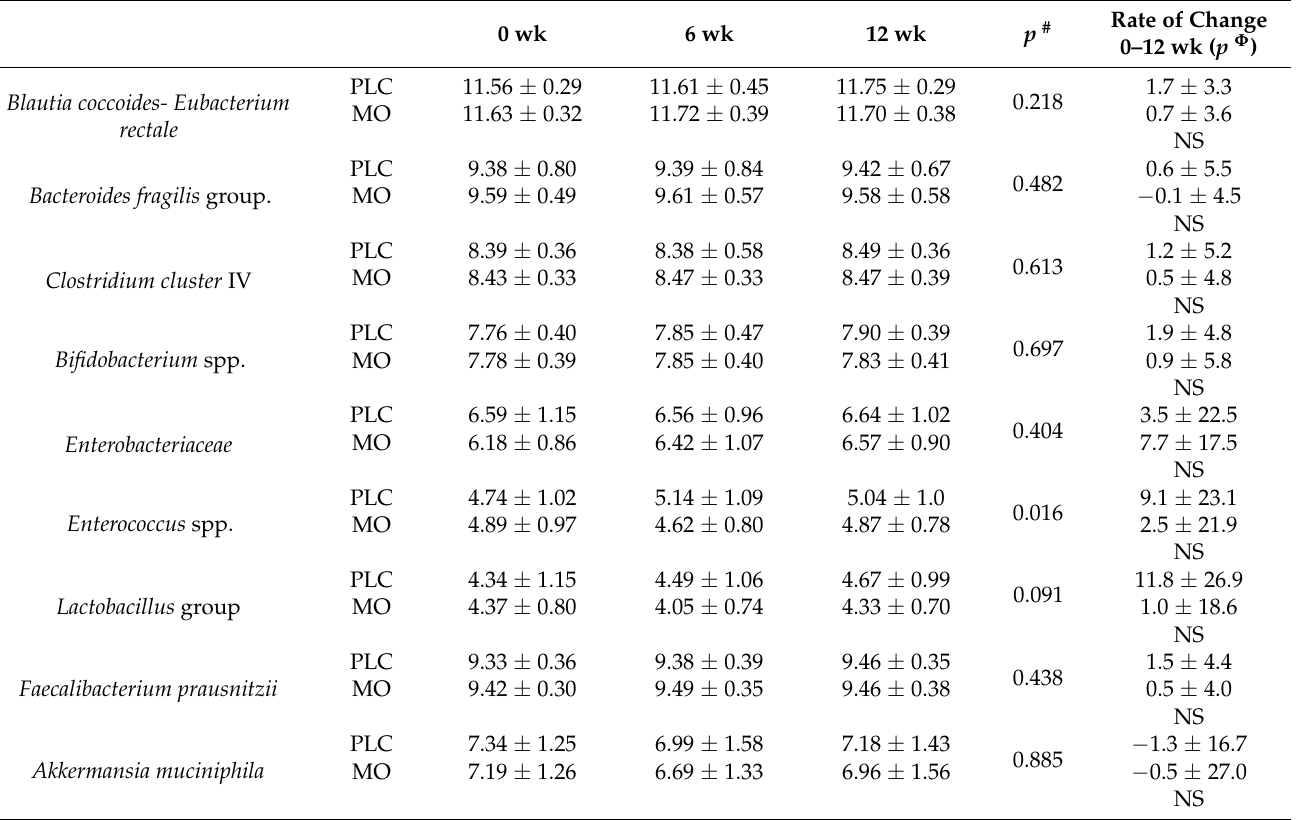
Table 4. Microbiota (log cfu/g feces) in patients with prediabetes of the PLC and MO groups during the